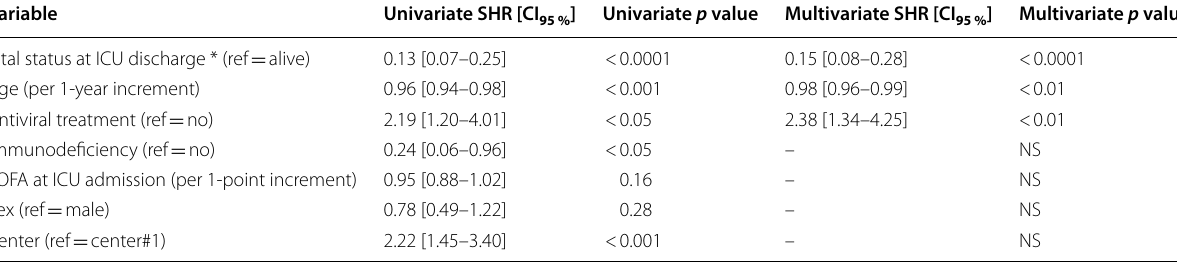
Table 2 Fine and gray competing risk regression of the probability of SARS-CoV-2 RT-PCR negativation